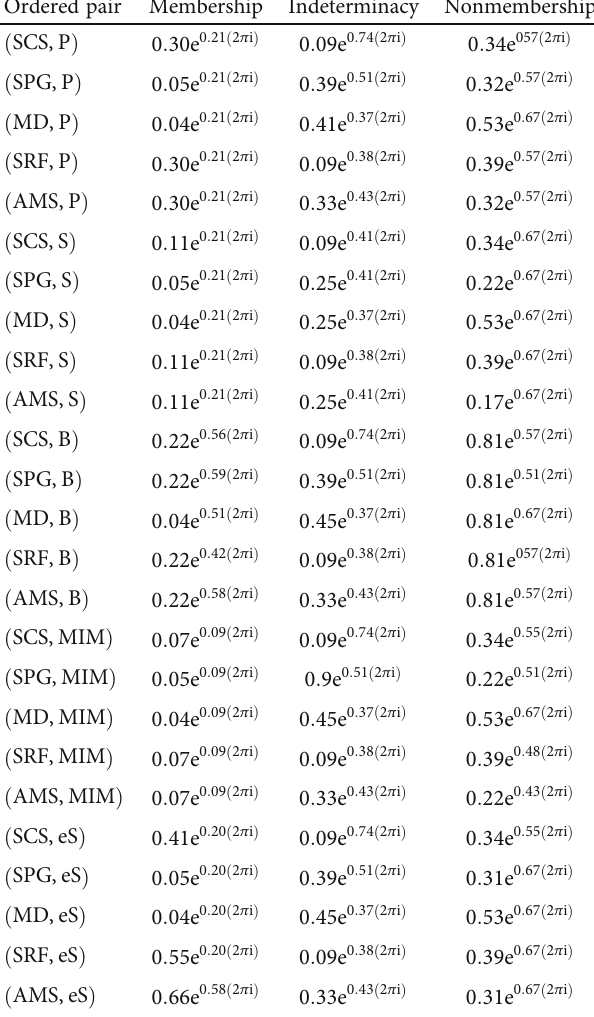
Picture fuzzy Interval-valued picture Ordered pair grades fuzzy